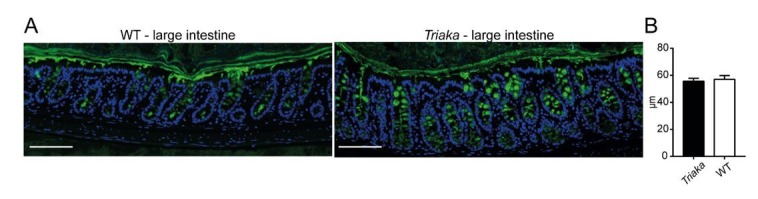
Analysis Mucin-2 (MUC2) layer.(A) Immunofluorescence for MUC2 (in green) was performed on colon tissue of the indicated strains. Nuclei were visualized with DAPI. Representative pictures are shown (scale bar: 100µm). (B) Thickness of the inner mucus layer was measured on MUC2 immunofluorescent stained slides (n = 4-5 WT and Triaka mice, with 3 individual measurements per mouse).